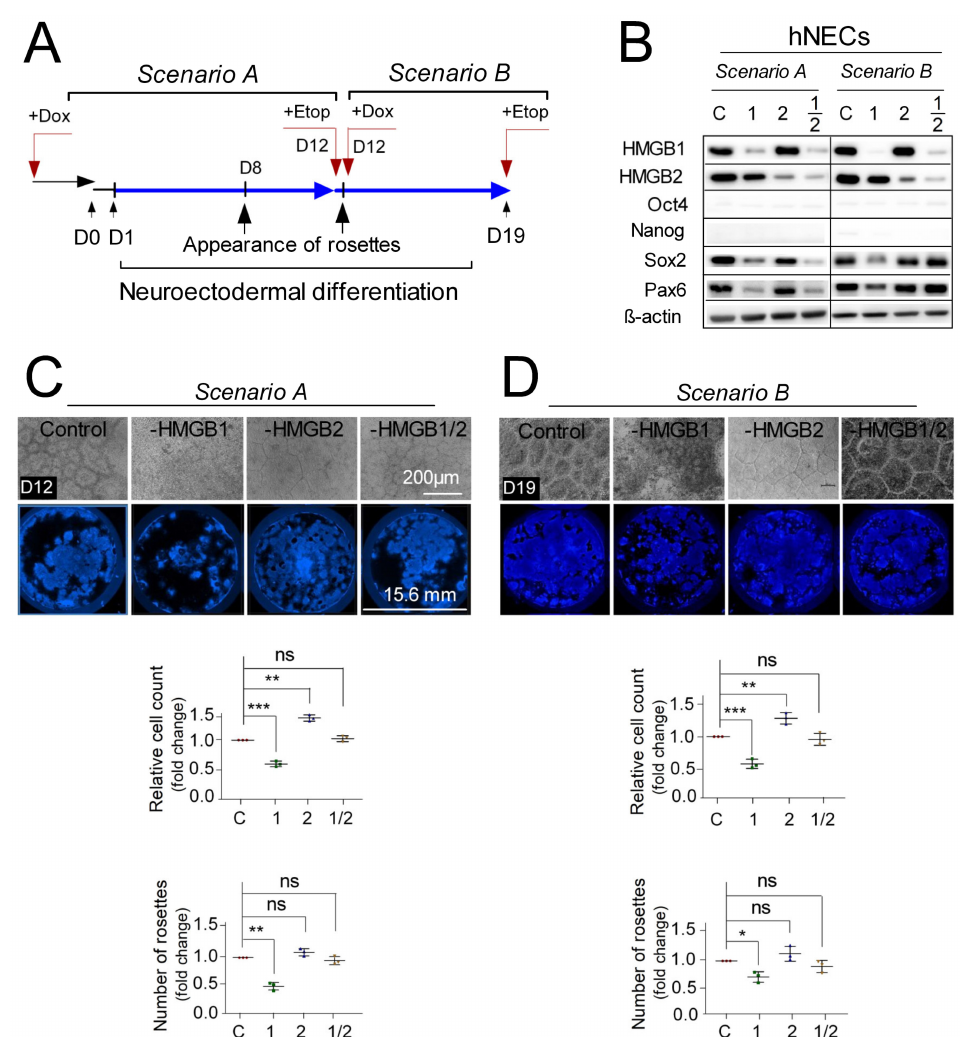
Figure 2. The distinct impact of HMGB1 / 2 silencing on the cell survival and di ff erentiation e ffi ciency of neuroectodermal cells. ( A ) Two scenarios for the di ff erentiation of hESCs into the neuroectodermal lineage. Scenario A: Undi ff erentiated hESCs were treated with doxycycline (Dox) for at least 3 days and subsequently induced to di ff erentiate (D1) into neuroectodermal cells for 12 days in the continuous presence of Dox in di ff erentiation media. On day 12 (D12), the cells were harvested for analysis. Scenario B: Undi ff erentiated hESCs were induced to di ff erentiate to human neuroectodermal cells (hNECs) for 12 days. At that point (D12), Dox was added to the di ff erentiation media, and the hNECs were allowed to grow for another 7 days in the presence of Dox. On day 19 (D19), the cells were harvested for analysis. ( B ) Expression of the pluripotency markers OCT4 and NANOG and the di ff erentiation-associated proteins SOX2 and PAX6 as determined by Western blotting of cellular lysates from hNECs prepared either by Scenario A or Scenario B. Equal loading of samples was verified using the anti- β -actin antibody. Description: “C”, cells transfected with empty vector; “1”, cells upon HMGB1 knockdown; “2”, cells upon HMGB2 knockdown; “1 / 2”, cells upon HMGB1 and HMGB2 knockdown. ( C , D ) Morphology of neural rosettes as visualized by phase contrast microscopy using an Image Xpress XL automated microscope (Molecular Devices, San Jose, CA, USA; top panels). Bar graphs indicate the relative number of hNECs and quantification of rosette structure formation upon HMGB1 and / or HMGB2 knockdown (lower panels; results are normalized to empty vector-transfected cells). Data were analyzed using Tukey’s multiple comparison test ( p > 0.05 = not significant, ns; * p < 0.05; ** p < 0.01; *** p < 0.0001) and represent the mean and SD of three independent experiments. Scale bars = 50, 200 µ